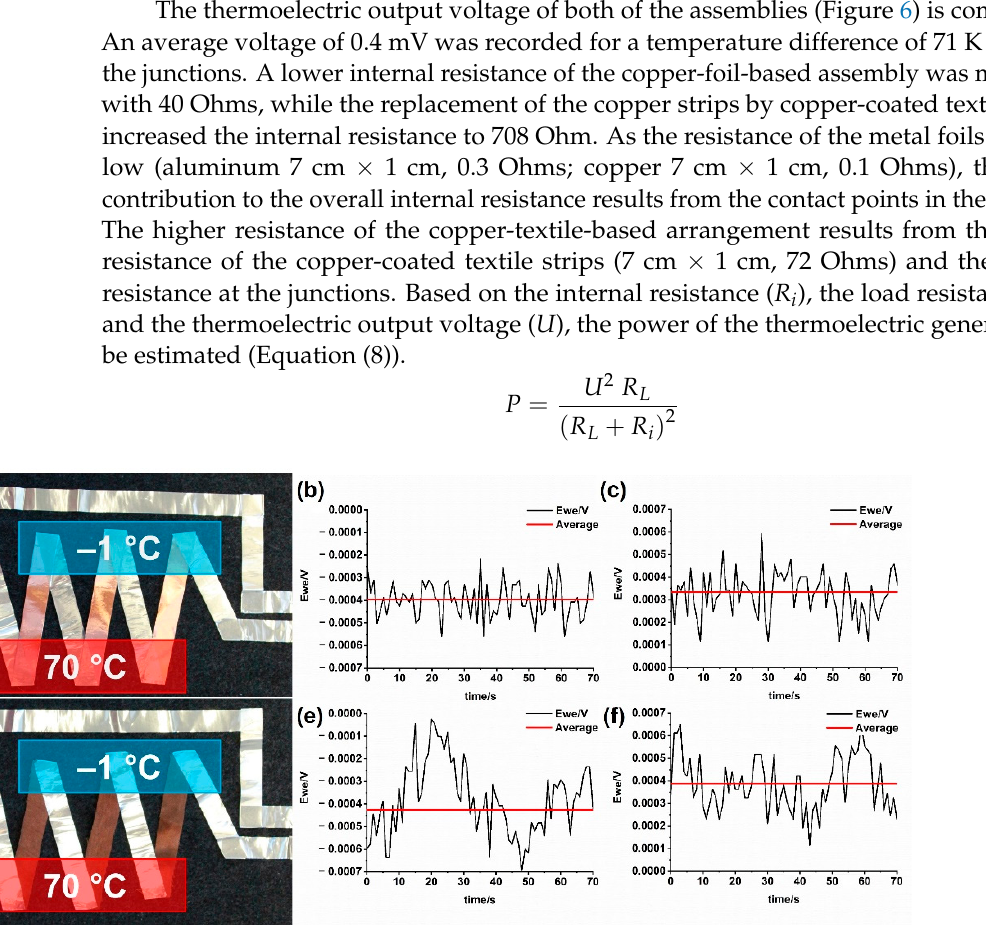
Figure 6. Thermoelectric output voltages of arrangements in series of three thermocouples using strips of copper and aluminum foils ( a – c ), and strips of copper-coated textiles and aluminum foils ( d – f ). Temperature difference 71 K, ( b ) Cu- strips + Al-strips, ( c ) same arrangement with reverted temperature gradient, ( e ) Cu-coated textile + Al-strips, ( f ) same arrangement with reverted temperature gradient.